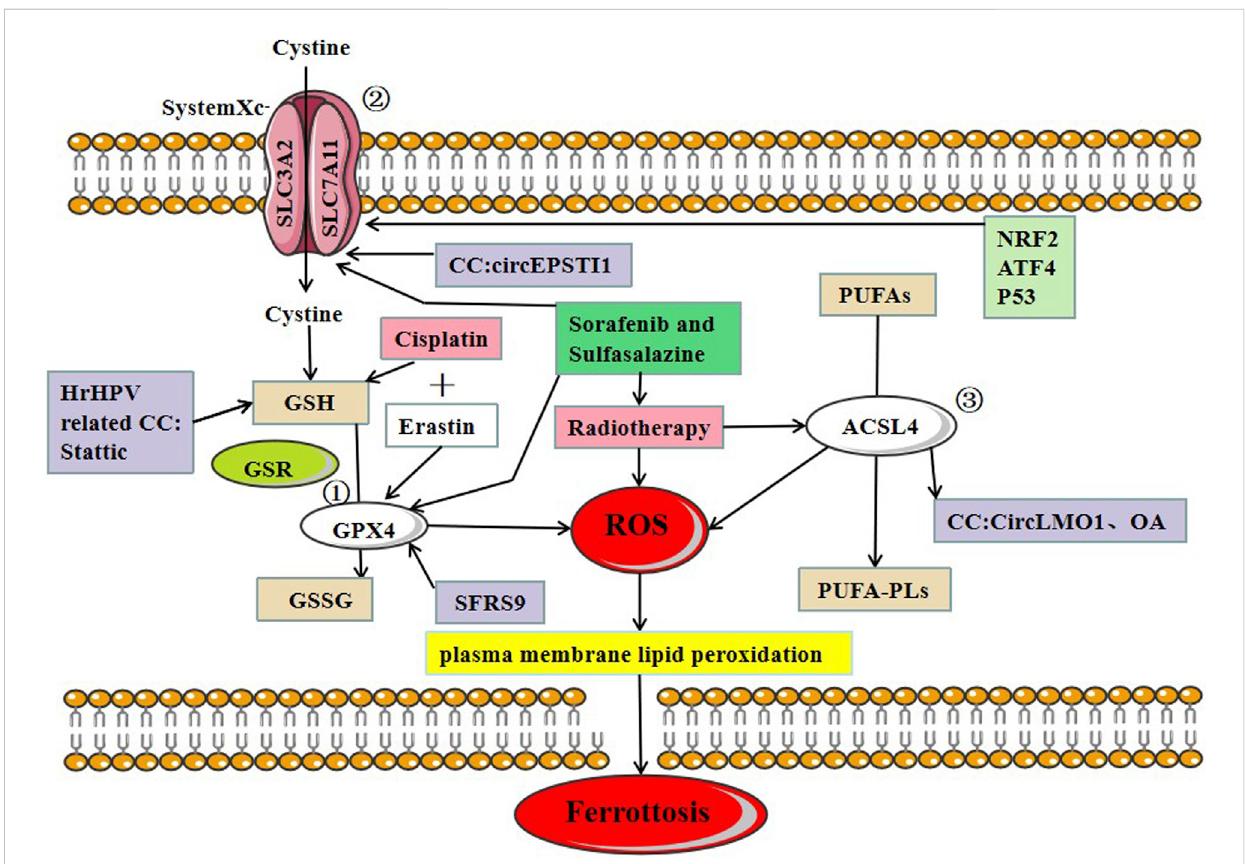
Three major regulatory mechanisms of ferroptosis in cervical cancer. ① GPX4 pathway: the SLC7A11-GSH-GPX4 (solute carrier family 7 members 11-glutathione-GPX4) signaling axis accounts for the predominant ferroptosis defense system. Cysteine serves as the rate-limiting precursor for the biosynthesis of GSH, a critical cofactor for GPX4 to detoxify lipid peroxides, ② SystemXc-: SLC7A11 is a core component of the cystine-glutamate antiporter system (system Xc-) and mediates the antiport activity of system xc − by importing extracellular cystine and exporting out intracellular glutamate, ③ ACSL4:PUFAsderivedfromlipidbilayersaremetabolizedbyACSL4leadingtotheproductionofROS.RecentresearchonferroptosisinCC has primarily focused on these three protein complexes. The main treatments for ferroptosis-related CC are cisplatin and